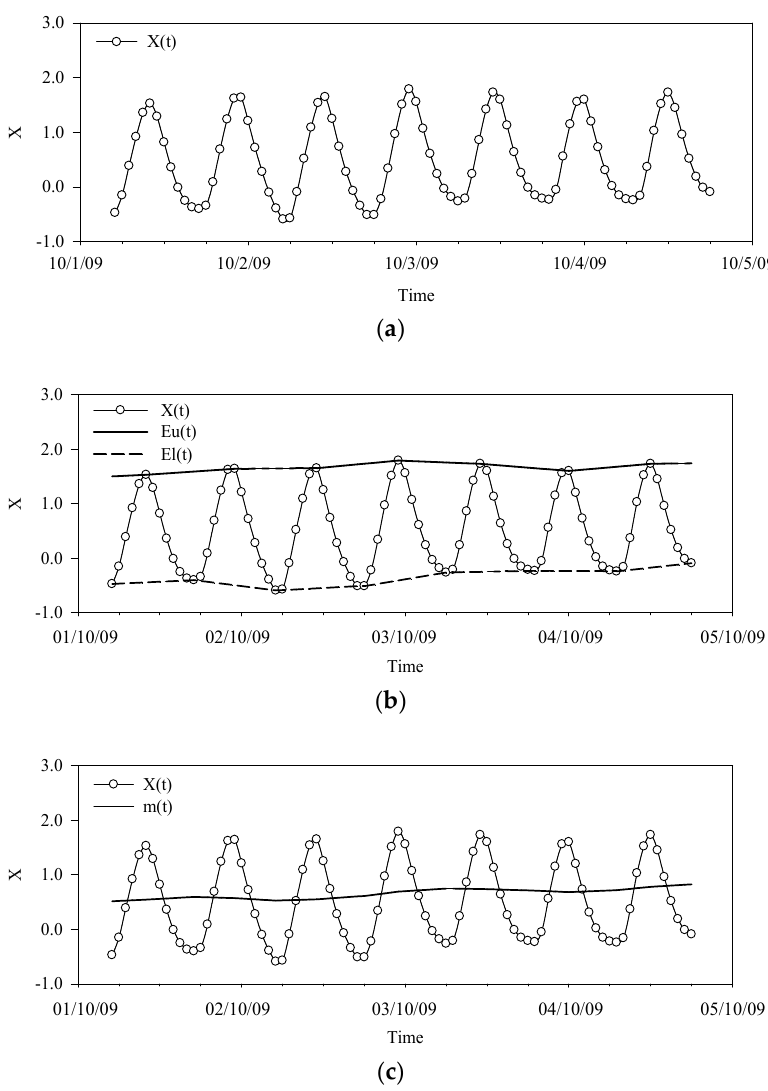
Figure 2. Definition of sifting: ( a ) Original data (water levels hydrograph); ( b ) Upper and lower envelopes; ( c ) Local mean value of the envelopes.